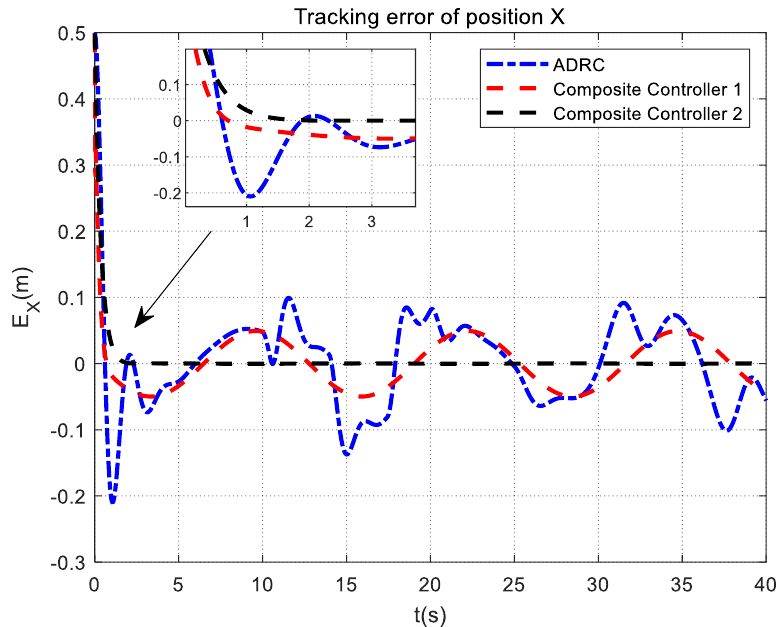
Figure 21. Tracking error of position X control for QUAV under actuator time‑varying fault and disturbance condition.